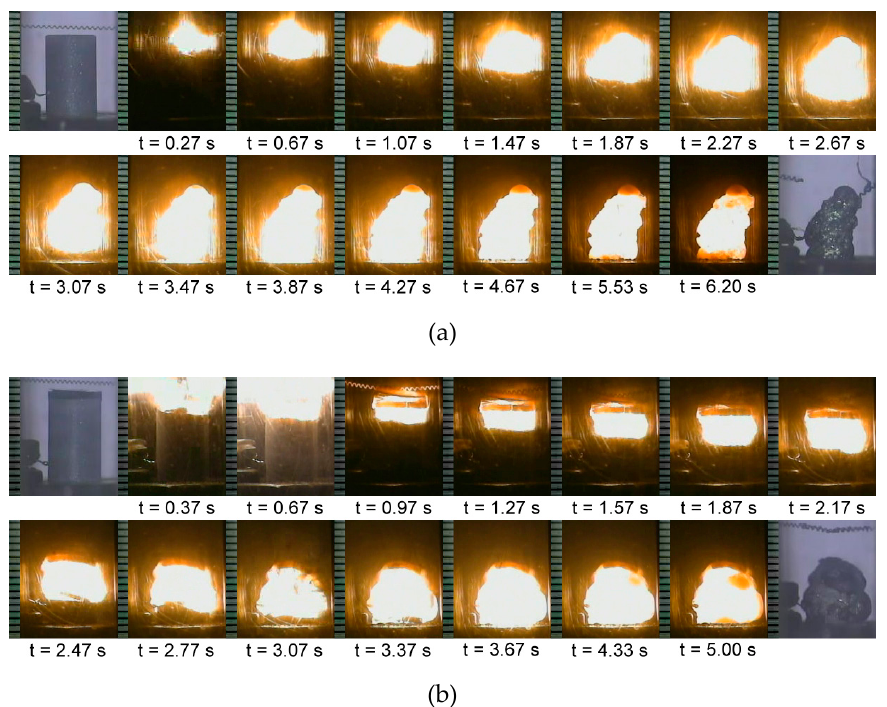
Figure 1. Self-propagating combustion images recorded from ( a ) Reaction (1) with x = 1.5 and ( b ) Reaction (2) with y = 1.75.